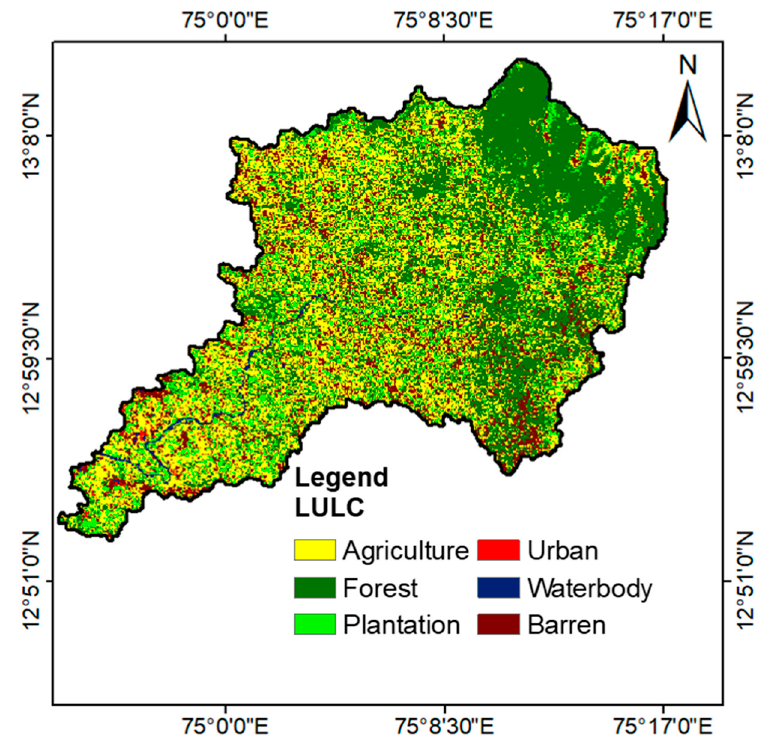
Figure 2. LULC used for the SWAT model.